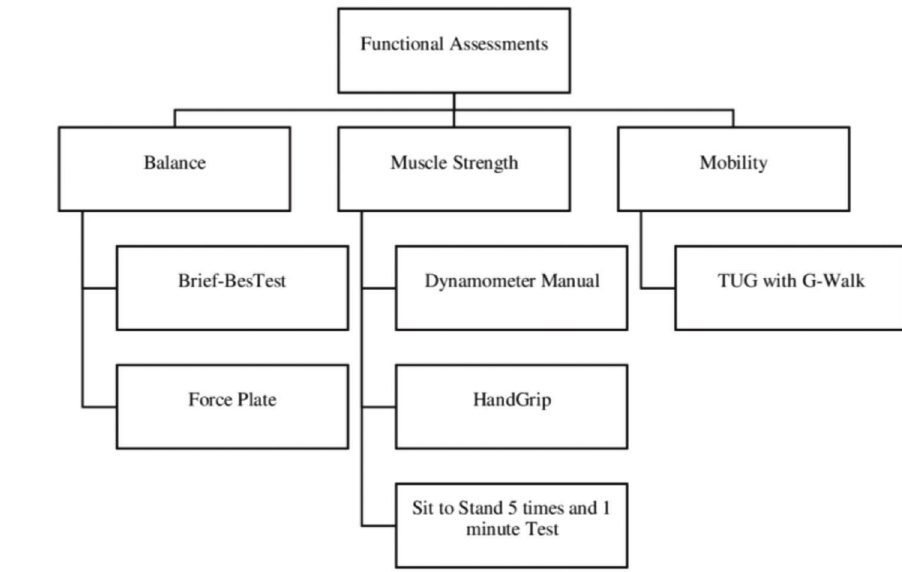
Figure 3 - Flowchart of tests applied for functional assessments.